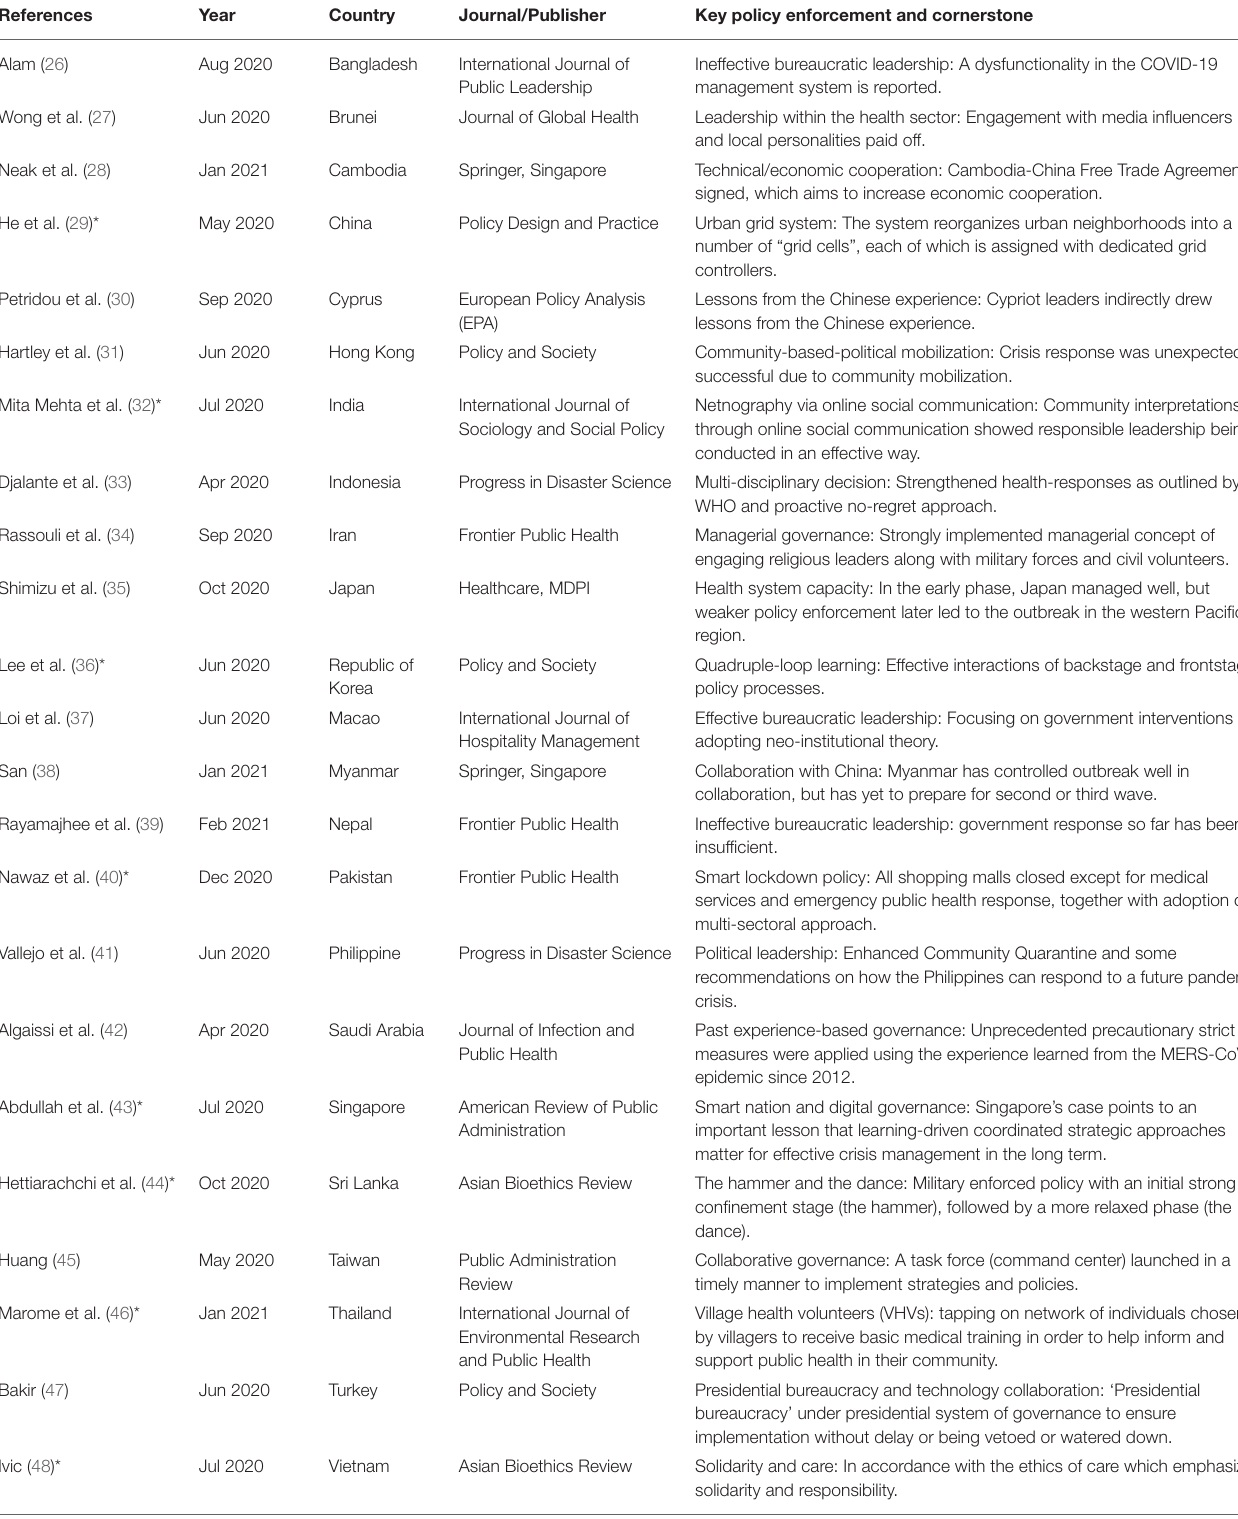
TABLE 2 | Characteristics of the included studies with key policy enforcement and cornerstones of COVID-19